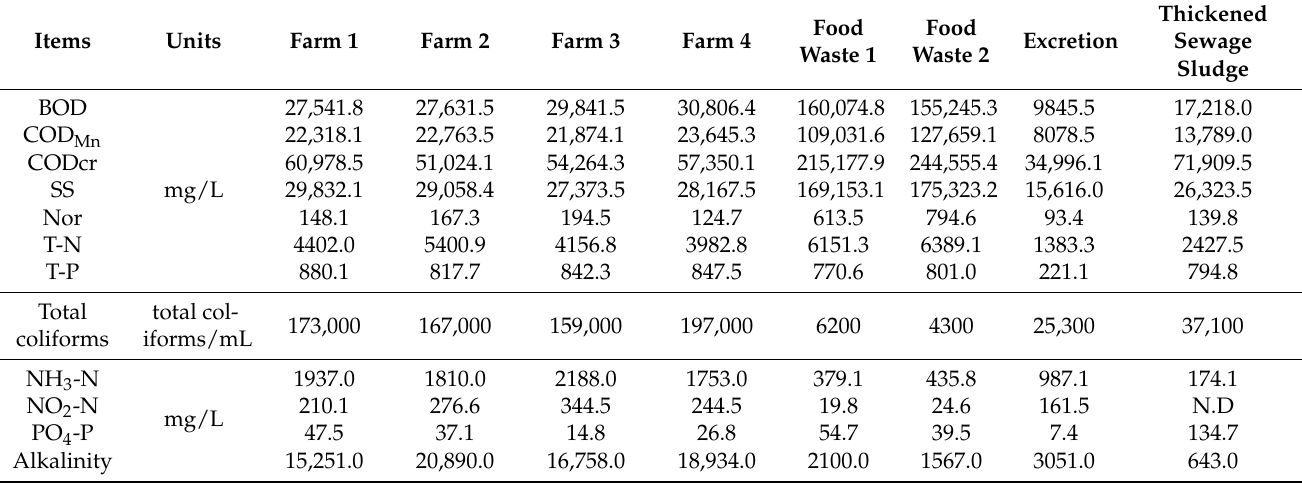
Table 7. Organic waste (pig manure, food waste, excretion, and thickened sewage sludge) sample analysis data (water quality analysis).